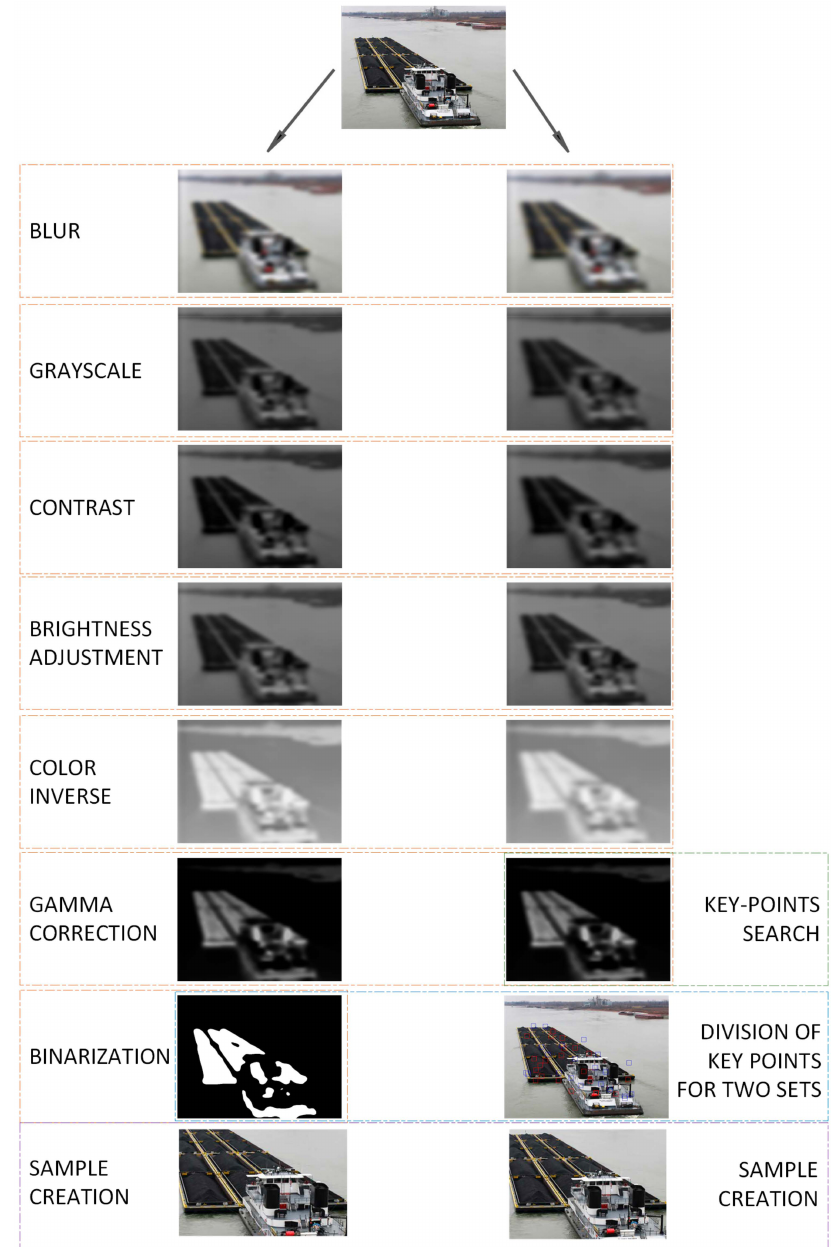
Figure 1. Graphical hierarchy of image